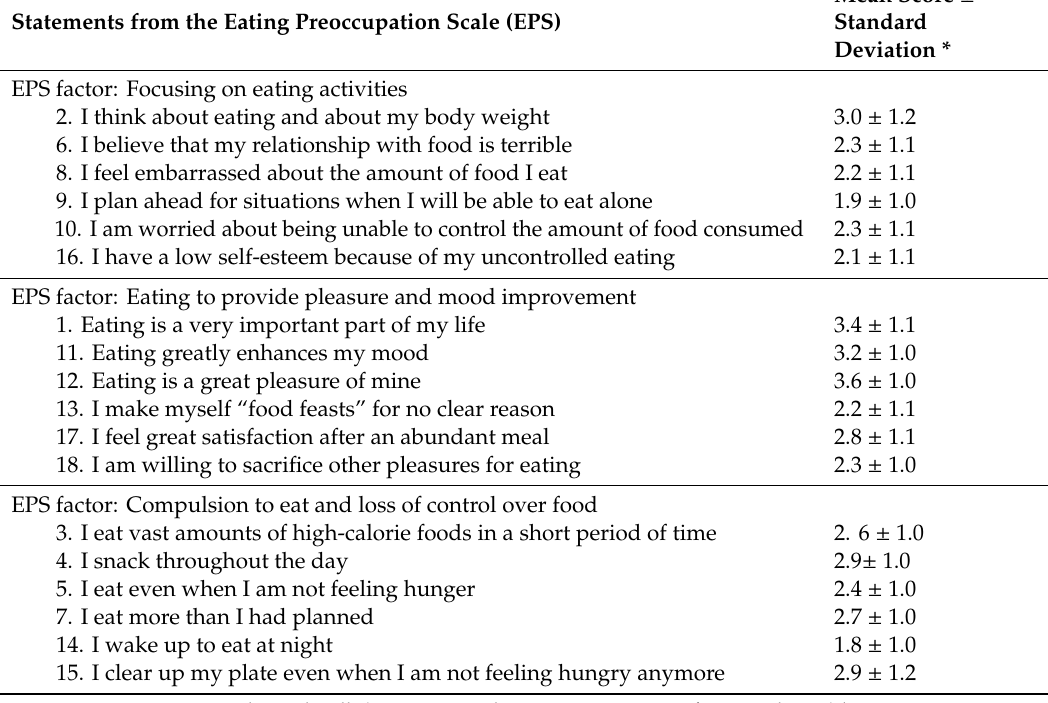
Table 1. The Eating Preoccupation Scale